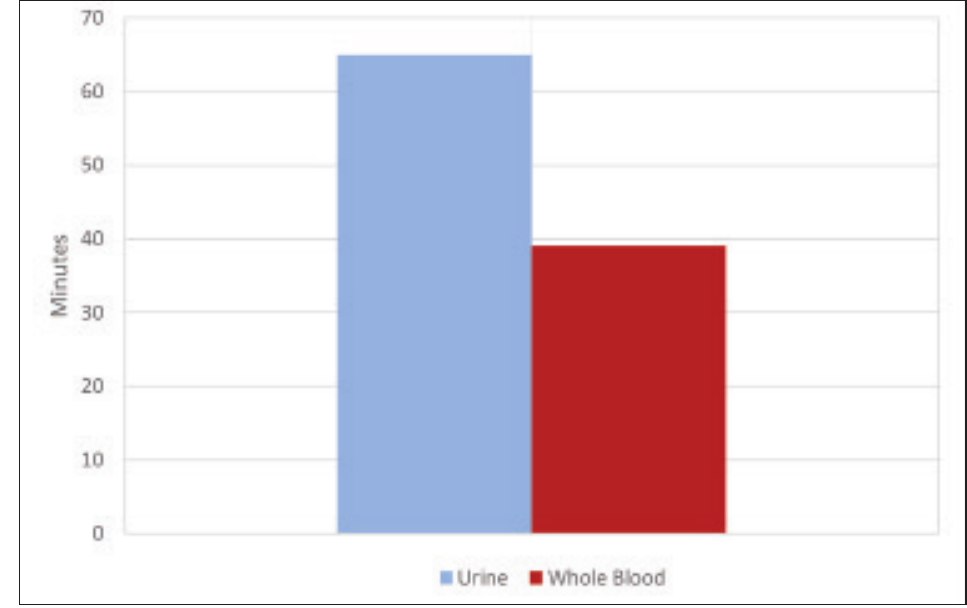
Figure 1. Difference in result turnaround times between whole blood and urine pregnancy tests.